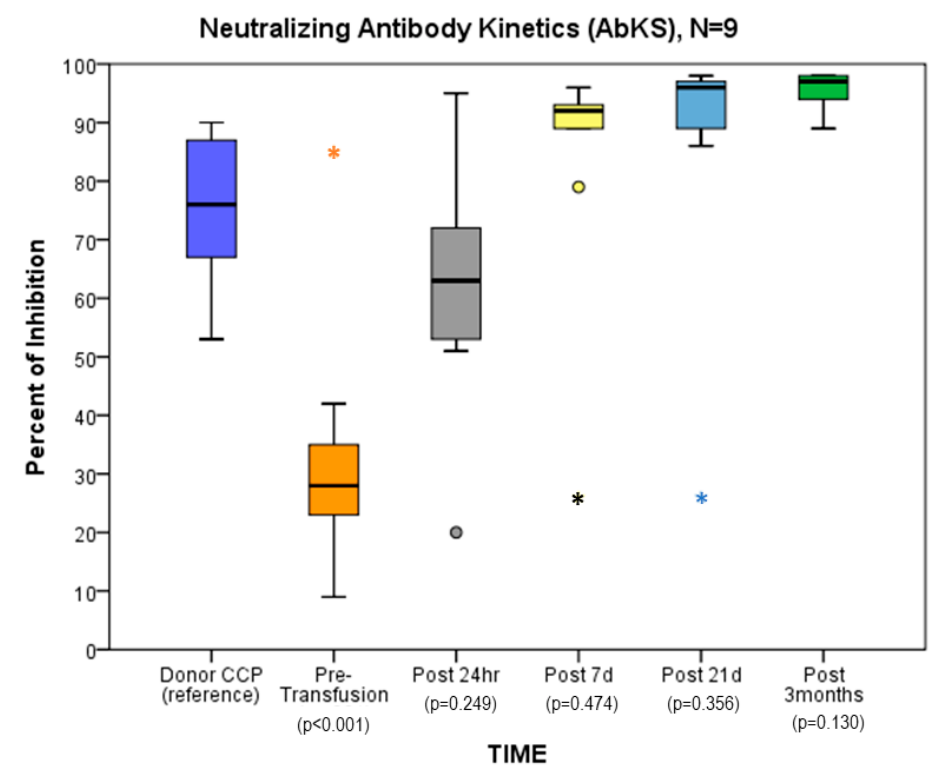
Figure 2. In 9 immune-competent hosts without underlying disease and a full dataset to three months out, average percentage of inhibition in relation to donor CCP depended on time since infusion ( p < 0.001). Significance based on GEE analyses with the specification of gamma distribution, repeat measures, and independent correlation structure. The dots represent outliers. The asterisk represents an extreme outlier.